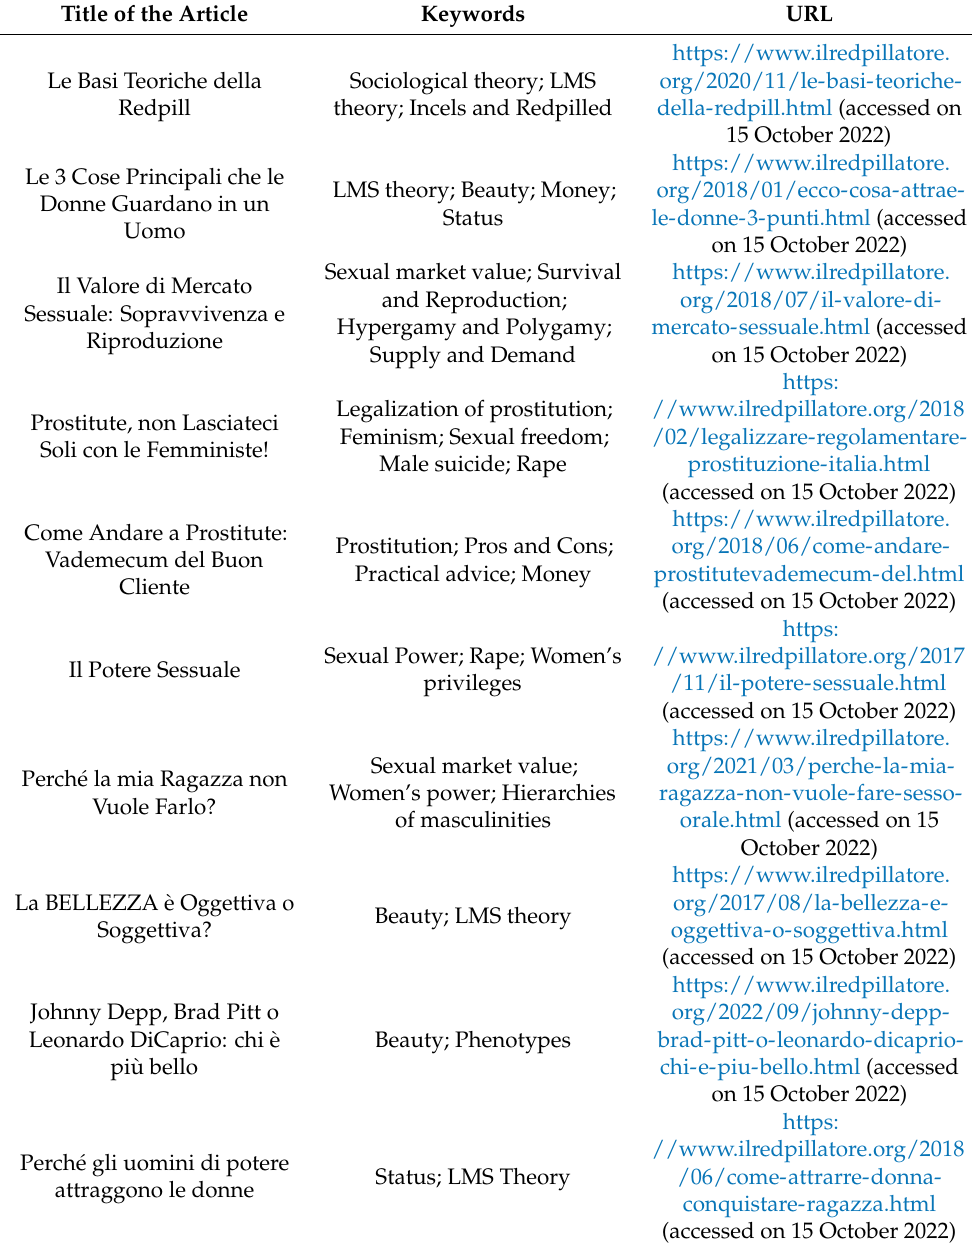
Table 1. List of consulted articles on the blog Il Redpillatore organized by title, keywords,